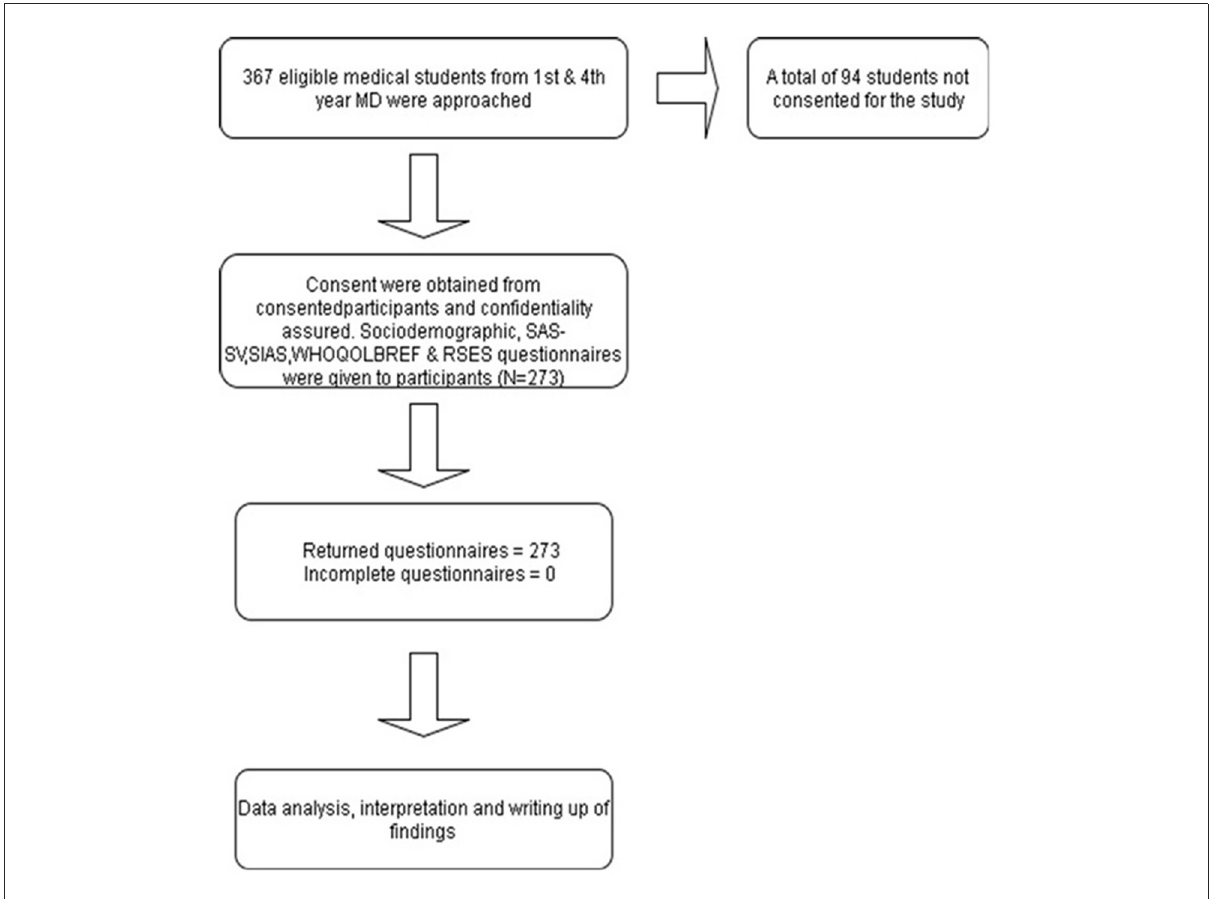
FIGURE1 Flow diagram of study